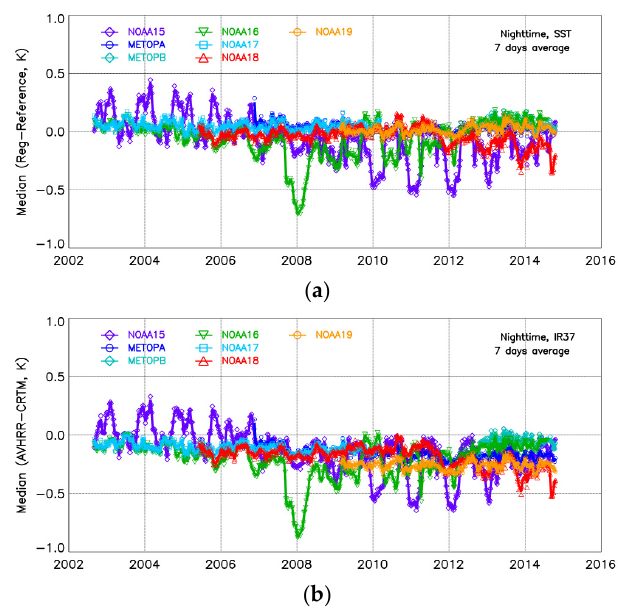
Figure 2. Mean nighttime ( a ) Δ T S = T S − T L4 and ( b ) Δ T B = T O − T M (in band 3b) corresponding to Figure 1a. Each data point represents a daily statistic based on matchups with CMC L4 SST (from 2.0 to 3.5 M; M = million).